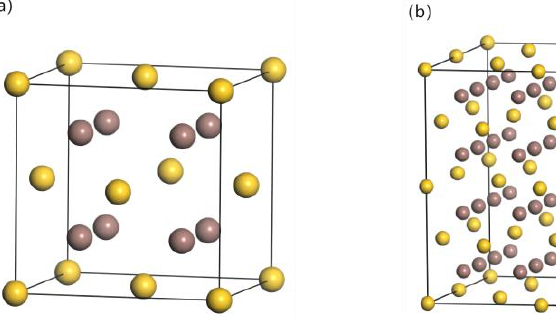
Figure 1. ( a ) AuIn 2 unit cell, ( b ) 2 × 2 × 2 AuIn 2 supercell, ( c ) RE doping sites in AuIn 2 supercell. The golden balls are Au atoms and the pink balls are In atoms. The blue sphere represents the doped RE (RE = Y, Sc) atom and the positions 1, 2 and 3 represent the octahedral interstice location of RE doping, RE replacing In atom and RE replacing Au atom,